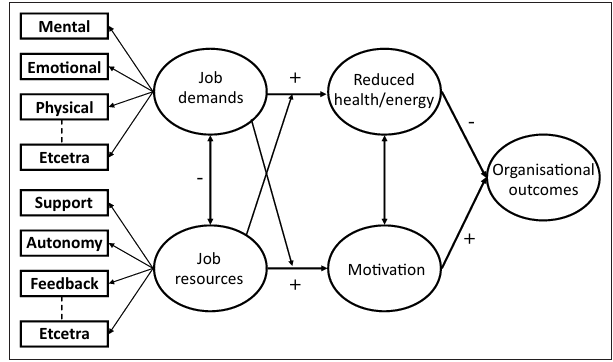
FIGURE 1: Two different underlying psychological processes play a role in the development of job-related strain and motivation. effects of effort expedition, the JD–R model expands these views and states that different types of job demands and job resources may interact in predicting job strain. Which job demands and resources play a role in a certain organisation and a certain job function depends upon the specific job